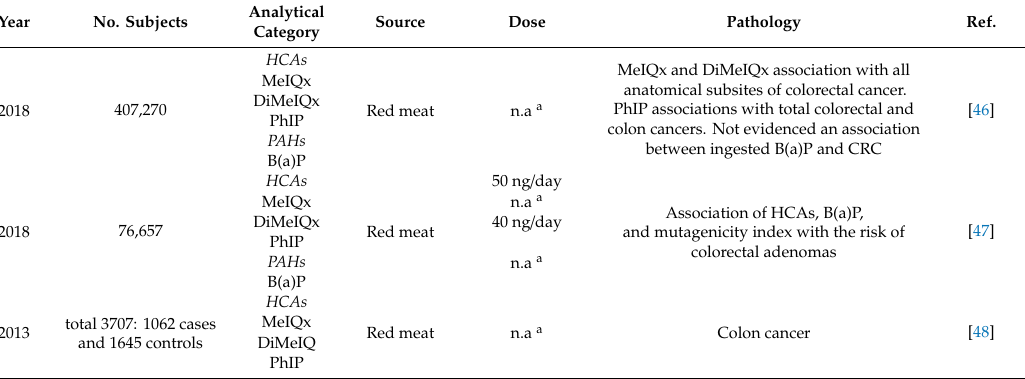
Table 1. Observational studies in recent years associating heterocyclic aromatic amines and polycyclic aromatic hydrocarbons with colorectal